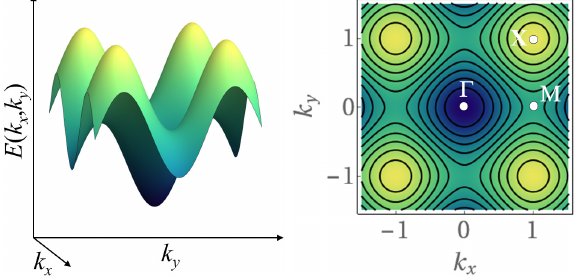
Figure 2. Band structure of a square lattice: the energy surface ( left ) and the isofrequency contours ( right ) in the ( k x , k y ) quasimomentum